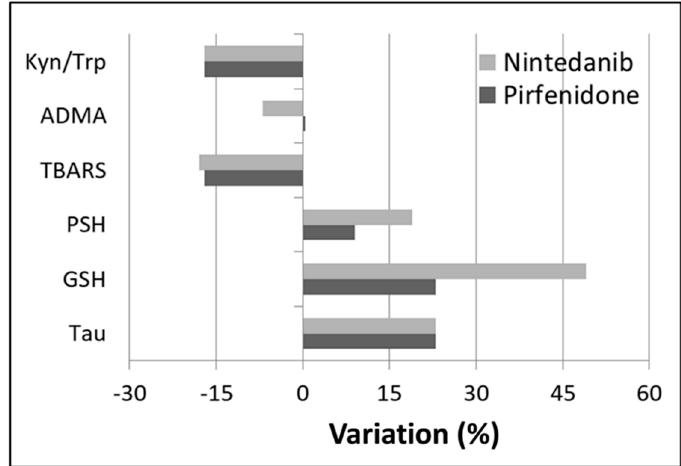
Figure 1. Most relevant percentage variation of biochemical parameters after 24 weeks of drug administration. Table 3. Clinical and biochemical characteristics of IPF patients at baseline and after 24 weeks of pirfenidone treatment.